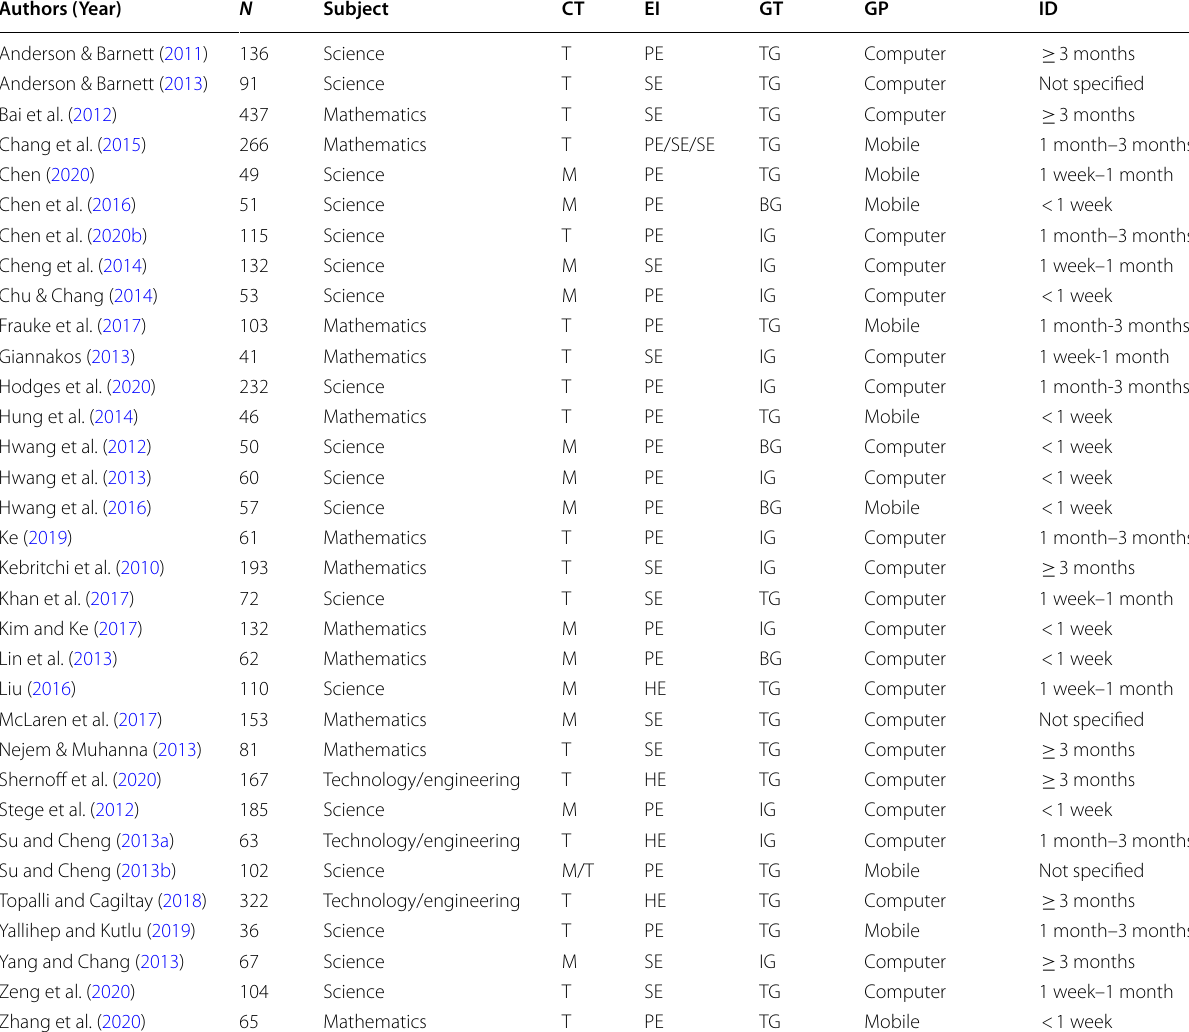
Table 1 All moderator information of the included studies